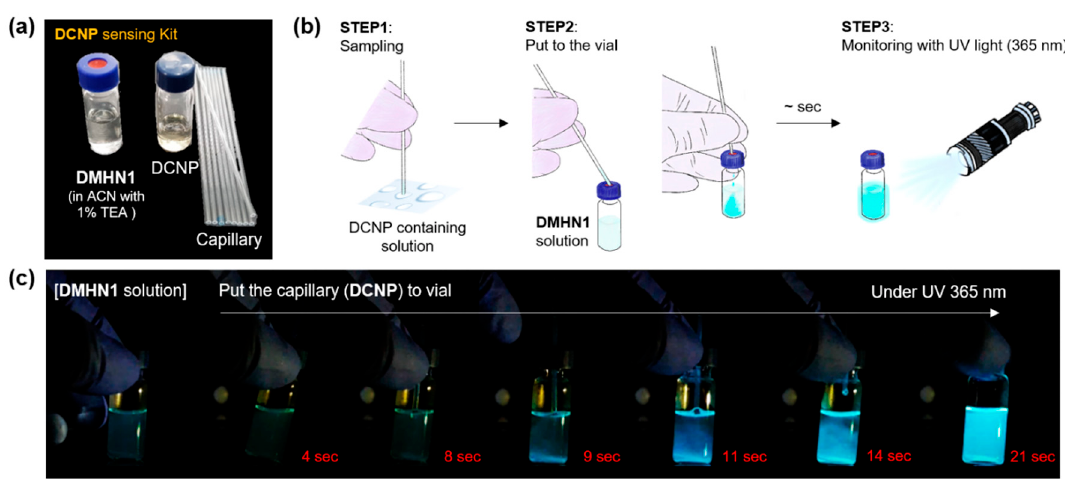
Figure 5. ( a ) Photos of DCNP sensing kit under natural light. ( b ) Schematic illustration of the DCNP sensing kit. ( c ) Photos of DMHN1 (10 µ M) in CH 3 CN (1% Et 3 N) and the progression after adding DCNP. Photos were taken from the video clip (Movie S1) at 2, 9, 11, 14, and 21 s at 25 °C. Table 1. Summary of known fluorescent probes for DCNP. *n.r.: not reported; DFP: